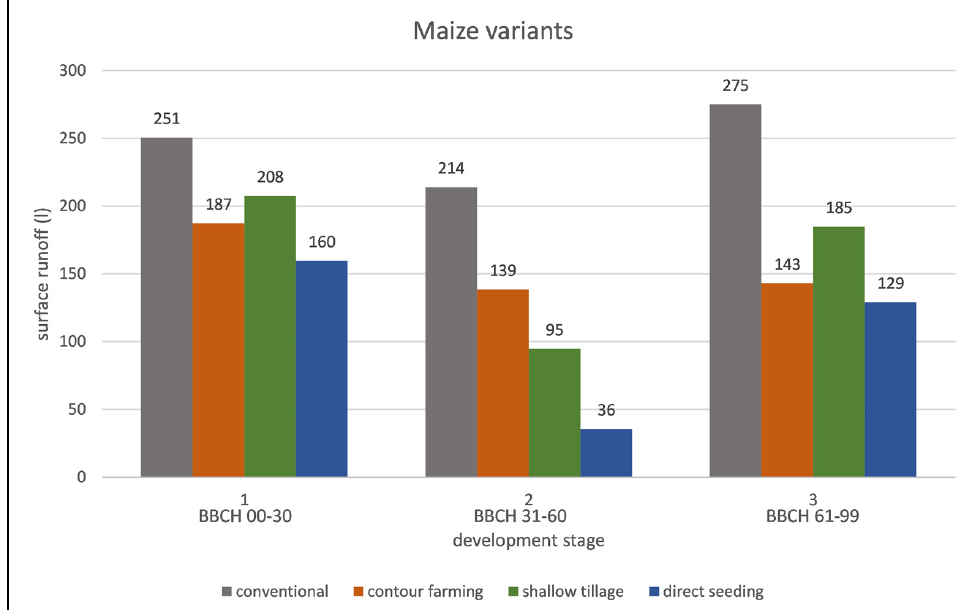
Figure 5. Surface runoff for different farming practices on maize, average of dry and wet conditions. The runoff ratio is the ratio of the total surface runoff from the experimental area divided by the rainfall precipitation for the duration of the experiment. The rainfall intensity was set to 60 mm · h − 1 , which corresponds to 960 L · h − 1 (the plot has an area of 16 m 2 ). Figure 6 shows that the retention effect of soil conservation technology is most significant in dry soil conditions. The runoff ratio in direct seeding is only 20% by the dry/wet average, whereas contour farming and shallow tillage reach levels around